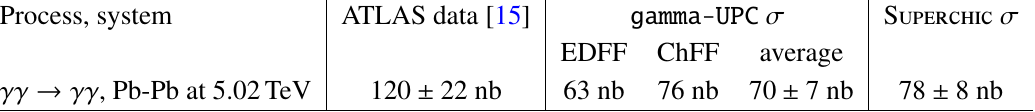
p = 5 : 02 TeV (with E (cid:13) s > T NN